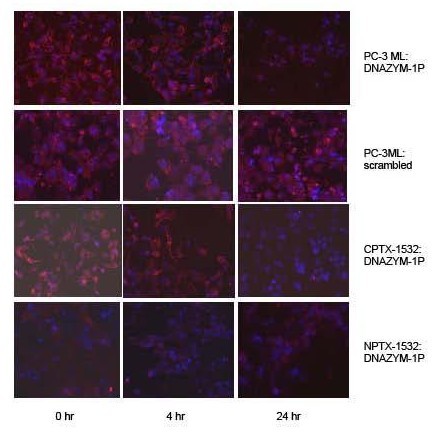
Immunolabeling of PC-3ML, CPTX-1532 and NPTX-1532 cells with RPS2 antibodies following treatment with 4 ug/ml DNAZYM-1P or scrambled oligonucleotide for 0, 4 and 24 hr. Cells were labeled with RPS2 P1 antibody (1:200 dil.) and Alexoflour secondary antibodies counterstained with DAPI. Cells were at ~70% confluence at the time treatment was initiated.